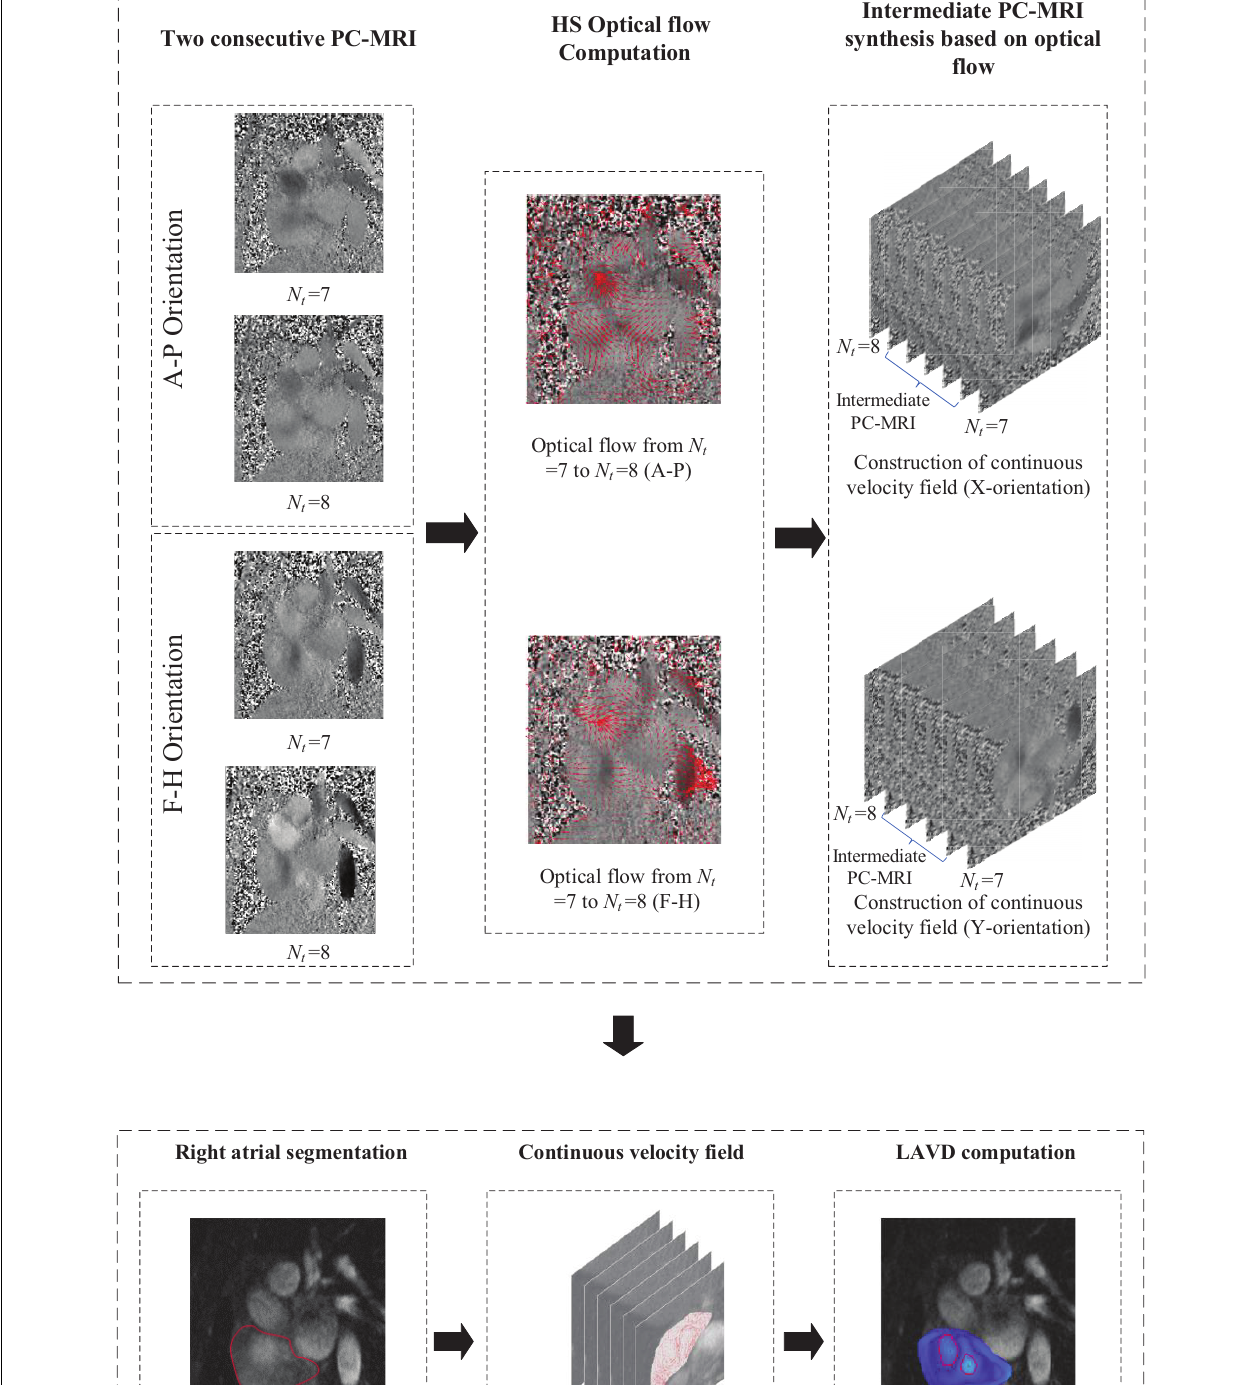
Frontiers in Physiology |